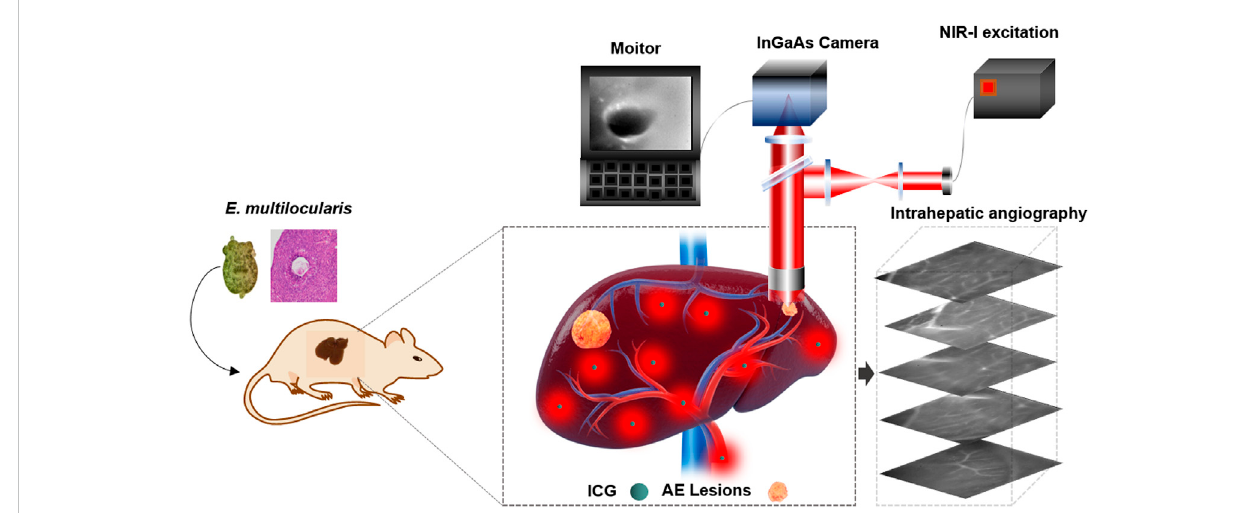
FIGURE 1 Schematic illustration of NIR-II fl uorescence imaging for recognition of hepatic microlesions in alveolar echinococcosis and intrahepatic